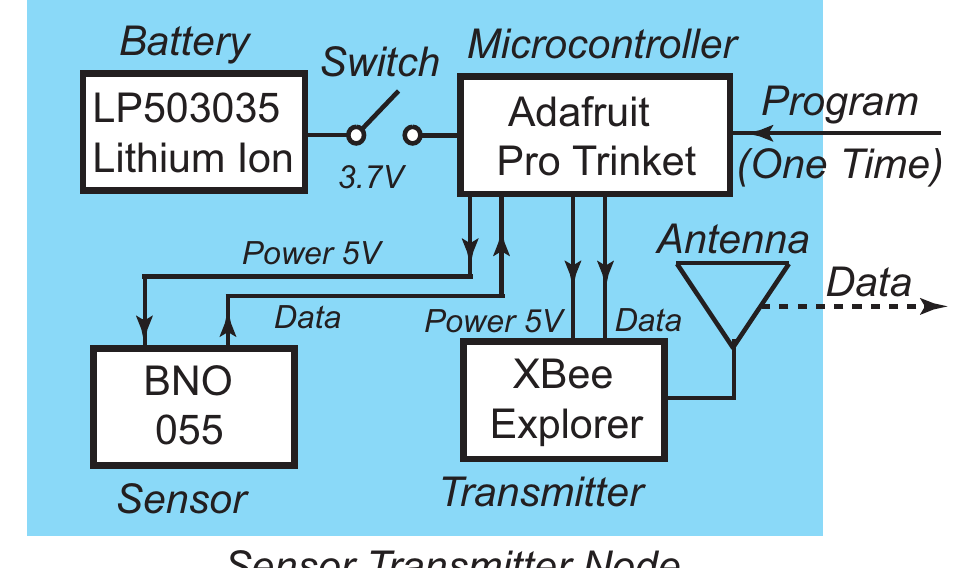
Figure 2. Simplified block diagram of the wireless motion sensor